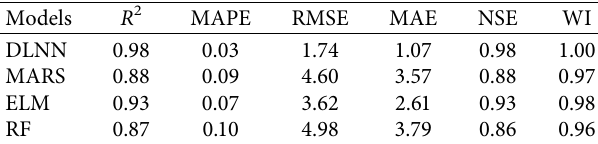
Table 6: Statistical measurements for the developed AI model in the test phase by using 70-30% data division scenario.